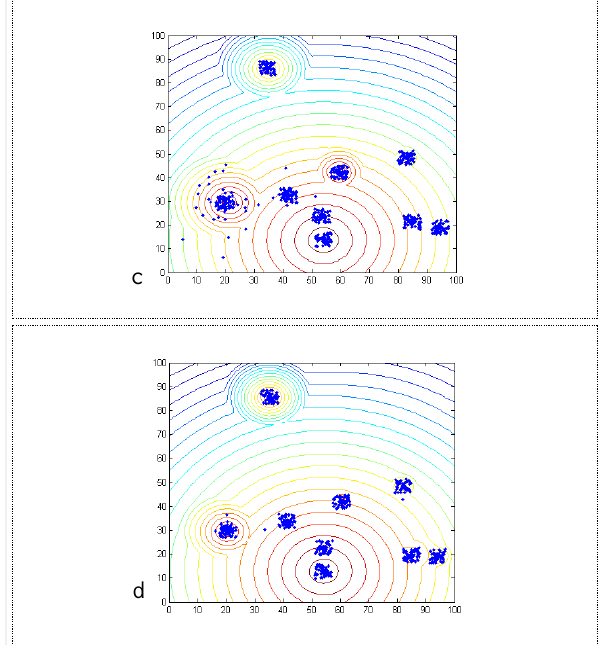
Figure 7. Trend of convergence individuals for peaks in through the run of the algorithm with population size = 100, peaks number = 10, frequency of change = 5000, and shift length = 1.